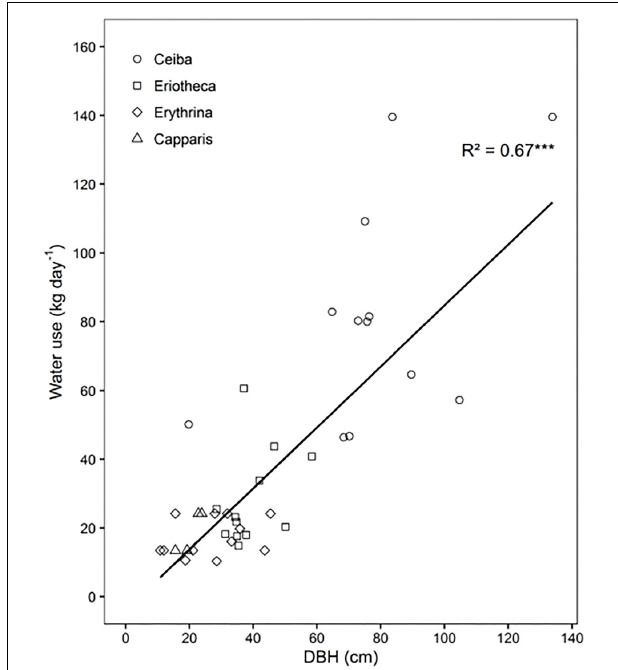
FIGURE 2 | Relationship between mean daily tree water use and tree diameter (DBH), n = 40, p < 0.001.